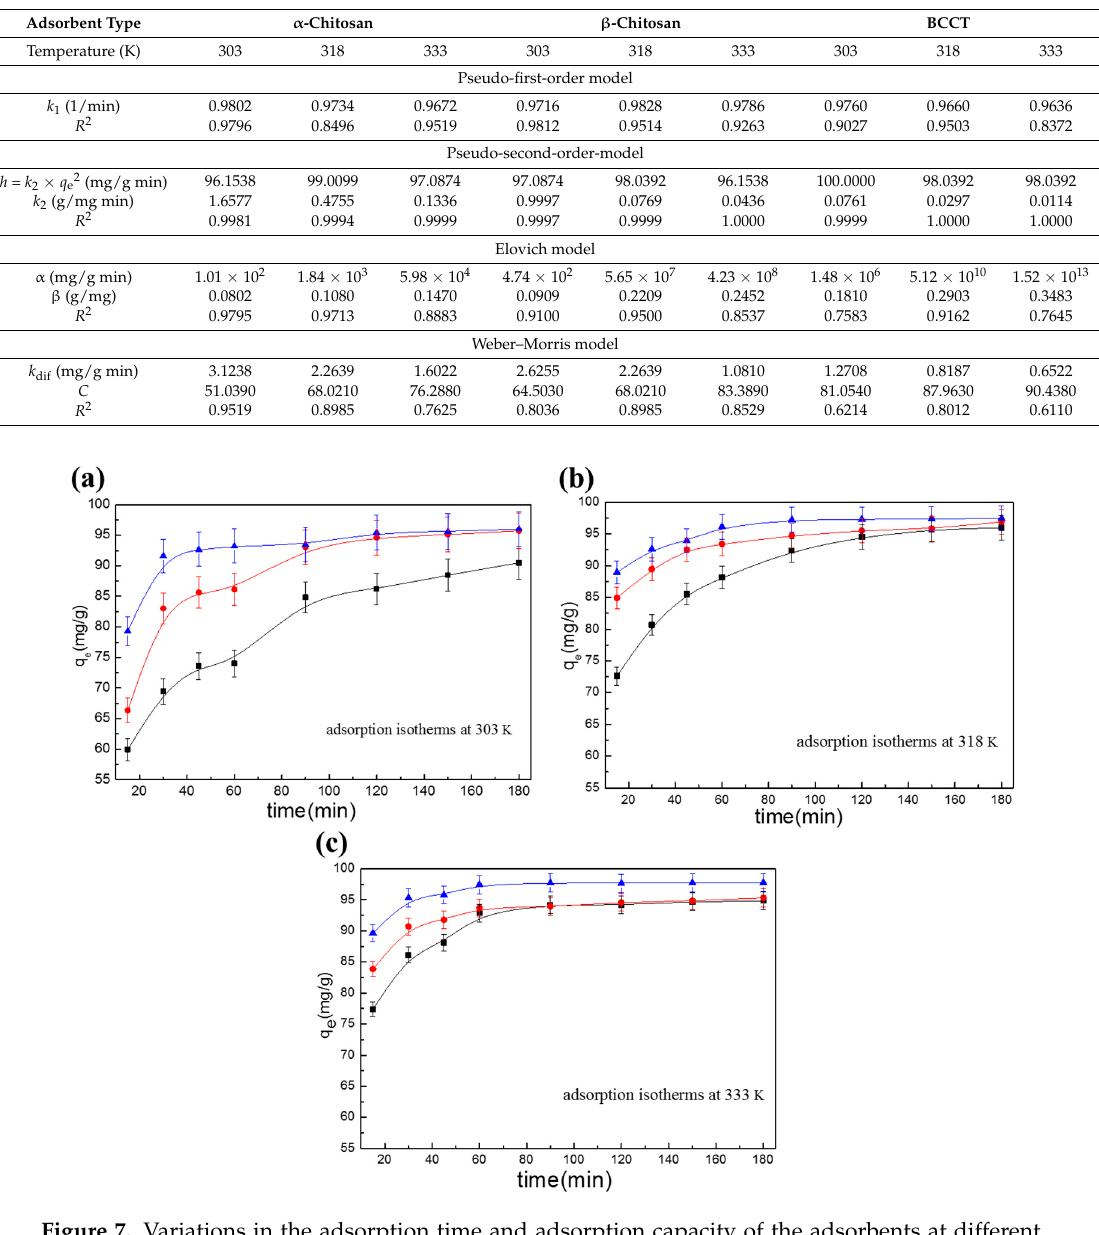
Table 3. Kinetic models of the adsorbents for the Reactive Blue 221 dye adsorption.